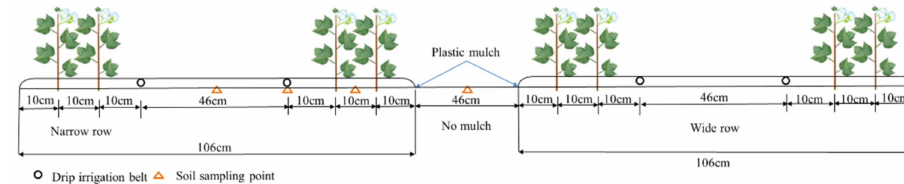
Figure 2. Schematic diagram of experimental planting mode and sampling